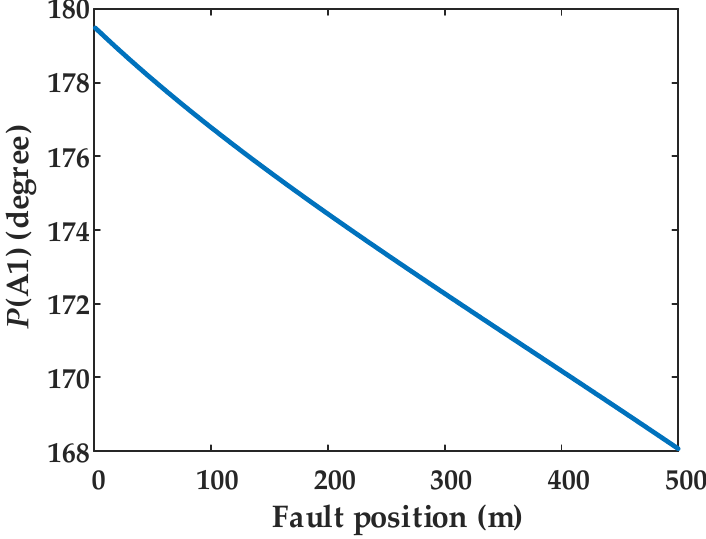
Figure 5. The phase difference between fault current I S and fault current I R when the fault occurred in cable section A1.